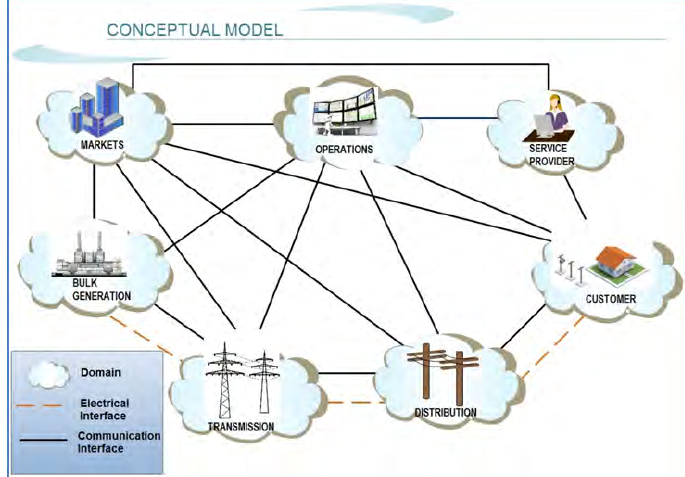
Figure 2. Smart Grid Reference Architecture by NIST, adapted from (IBM,